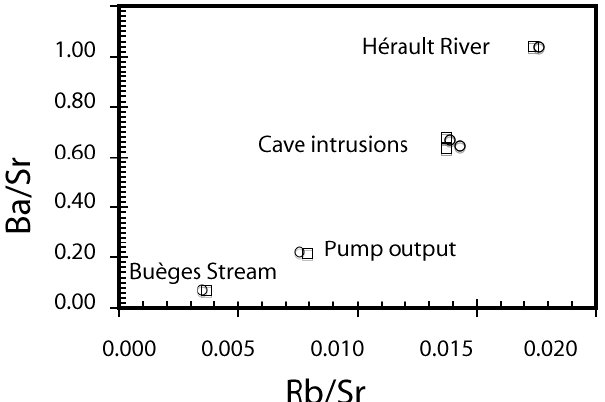
Figure 7. Plot of Ba/Sr vs. Rb/Sr (see Table 3). The alignments of points are characteristic of a two-pole mixing between Buèges and water Hérault. Two dilutions have been applied on the samples before ICPMS analyses (open squares: dilution by a factor two, open circles: no dilution). Assuming that Buèges water composition is characteristic of the far field water composition, we can write, after Vidal [45]: Q NAI = Q P (c P − c UAI )/(c NAI − c UAI ), where c P , c UAI and c NAI respectively stand for mass concentrations of Rb, Ba and Sr in Q P , Q UAI and Q NAI (Table 3).